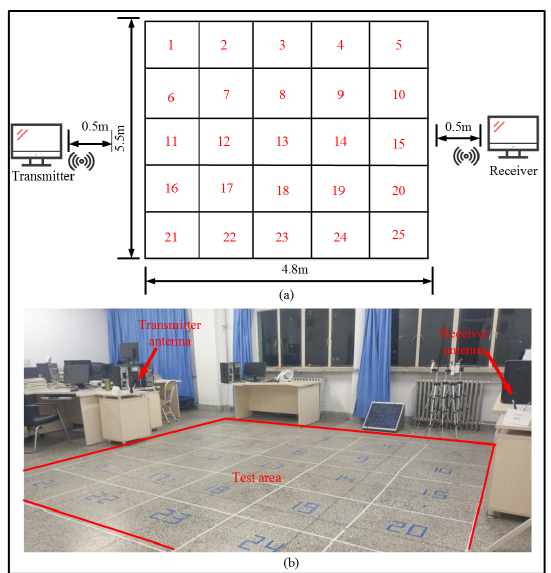
Figure 7. Experimental scene: ( a ) Experimental scene logic diagram ( b ). Real experimental site deployment.